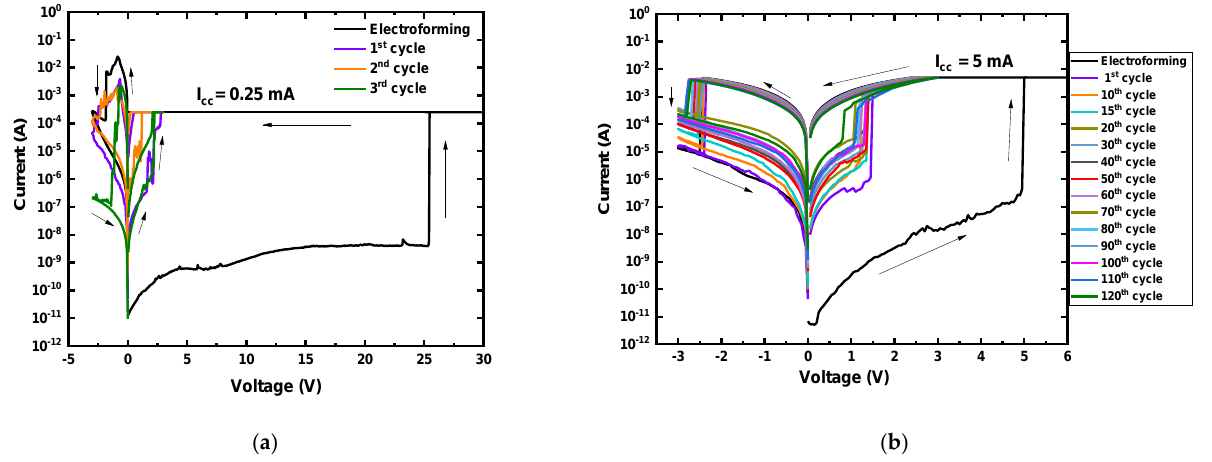
Figure 4. Typical I − V characteristics of post-deposition air− exposed MgF x based Ti/MgF x /Pt memory devices. ( a ) in open − air; ( b ) in vacuum.